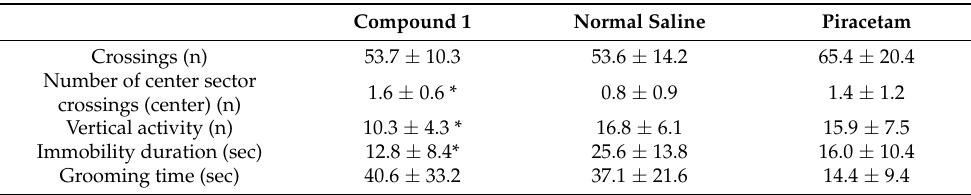
Table 2. Animal activity in the open field test (OFT).